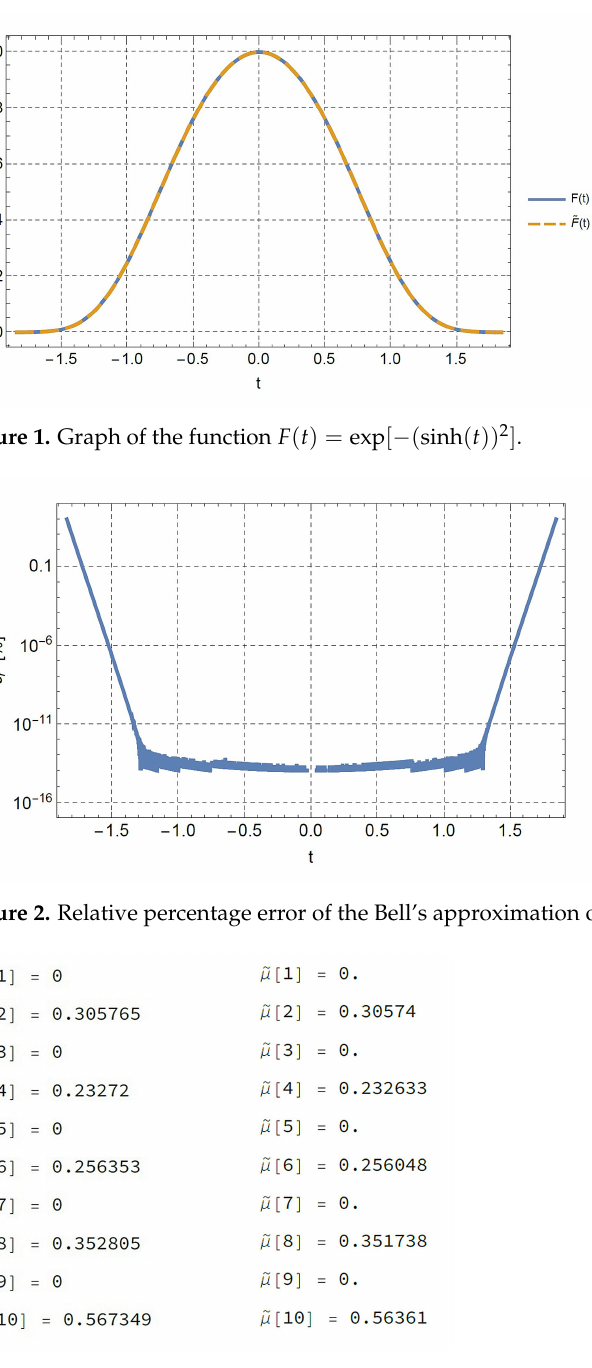
Figure 3. Moments of F ( t ) in (27) as computed using the G-KQR ( left ) and the proposed Bell’s polynomial approximation ( right )